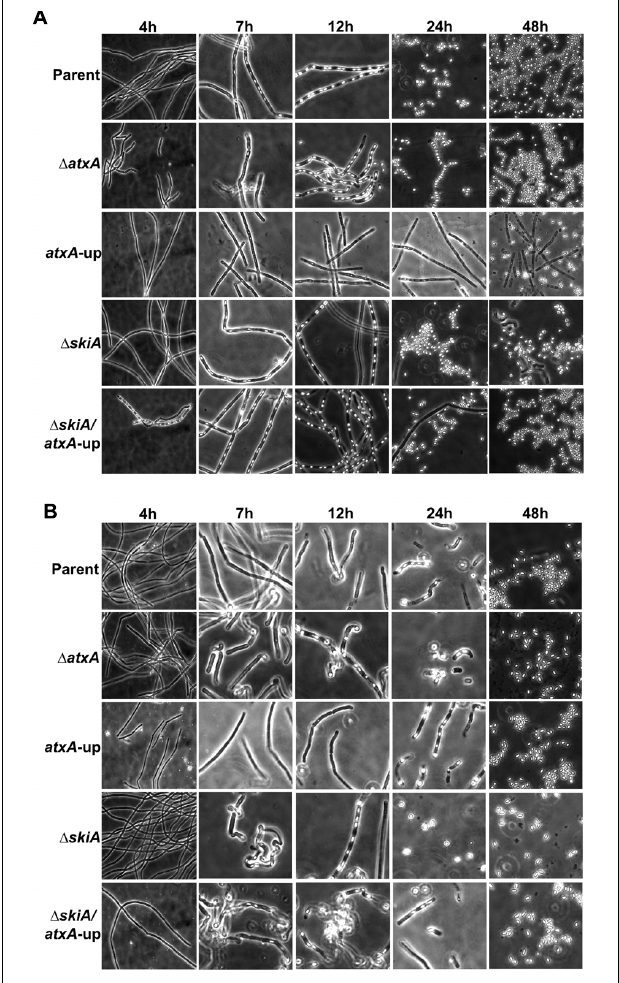
FIGURE 2 | Phase contrast microscopy showing sporulation. (A) Cultures in PA-air, or (B) CACO 3 +5% CO 2 . (cid:49) skiA is equivalent to (cid:49) pXO2-0075. The data are representative of three separate